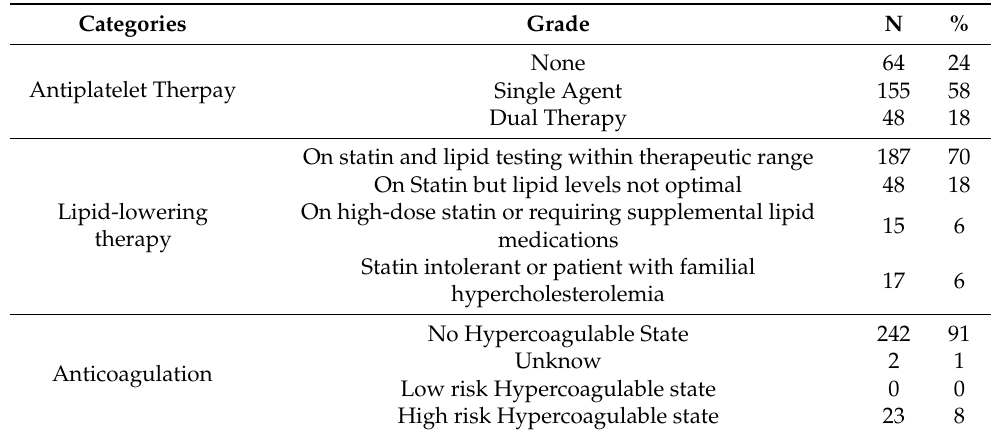
Table 2. Medical Therapy before intervention.